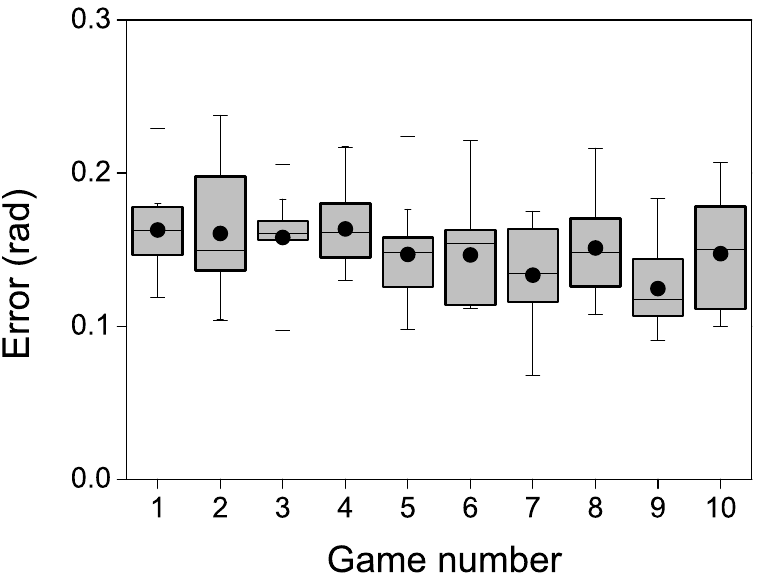
Fig 3. Constancy of the response error throughout the playing history. Box histograms of the sample distribution of the absolute value of the error, averaged in target colors, in 10 consecutive runs of the game. The error of player i in the ð j Þ (cid:0) t ð j Þji , where the angular brackets represent an average over the 32 target colors j . Each k -th game is defined as hj r i k box represents the histogram collected from the 11 players ( i 2 [1, 11]). Dot: sample mean. Horizontal line: sample median. Upper and lower borders of the box: 25% and 75% percentile of the responses. Whiskers: 5% and 95%. Horizontal bars: maximum and minimum